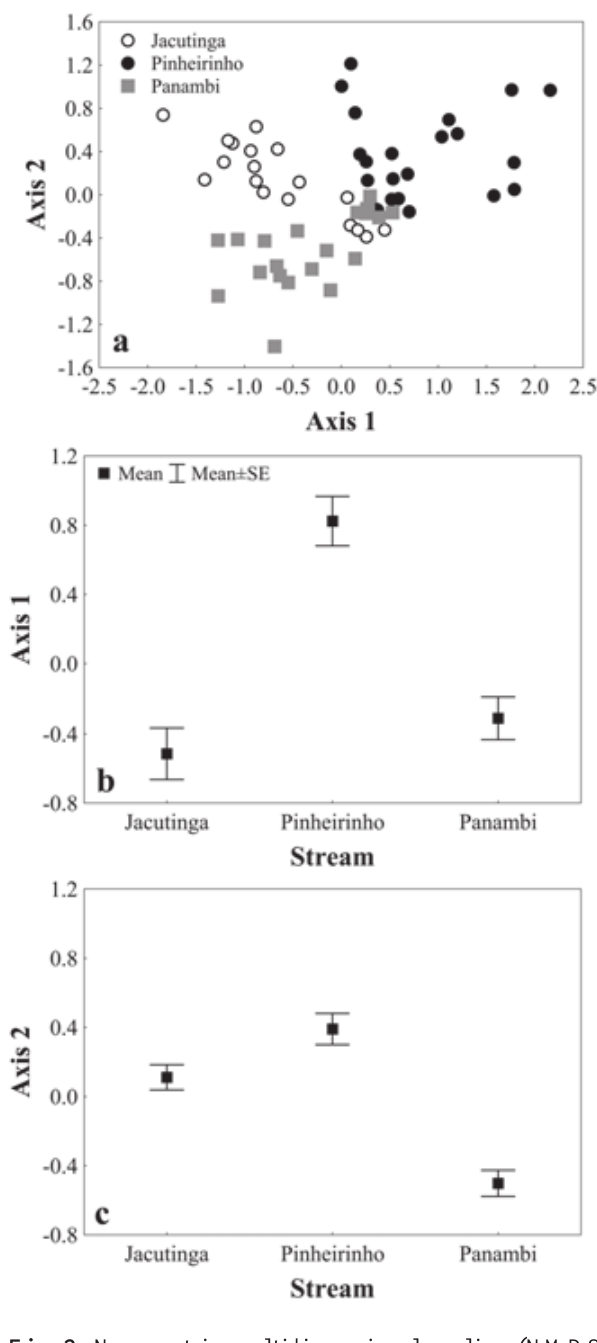
oxygen. However, morphometric variables were not significant (PROTEST; m 2 = 0.94; p = 0.053) corroborating the lack of association between morphometric variables and the distribution of fish assemblage.